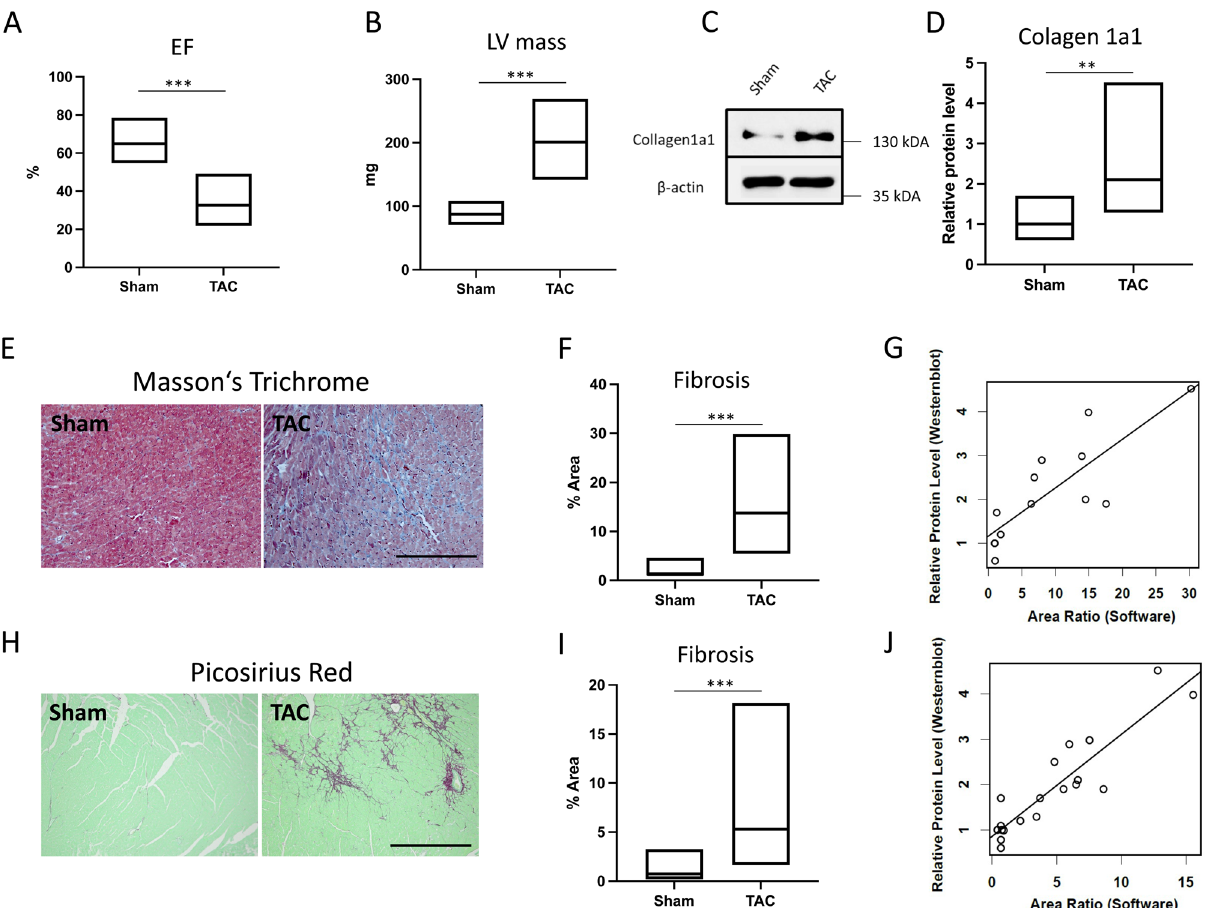
Figure 5. The results obtained by using the FibroSoft software strongly correlate with the results of Western blot analysis of collagen 1 in TAC model of heart failure. ( A ) Reduced cardiac function following TAC surgery in mice, measured by echocardiography. ( B ) Statistical quantification of left ventricular mass in mice subjected to TAC. ( C , D ) Analysis of collagen 1a1 expression in myocardium of mice by Western blot. Tubulin served as a loading control, proving equal loading of protein samples. Values were normalized to sham operated mice. ( E ) Representative images showing Masson’s Trichrome staining of cardiac paraffin sections in TAC and sham operated mice. Blue areas represent extracellular matrix deposition, while red stained tissue accounts for heathy heart muscle. ( F ) Statistical quantification of percentage fibrosis area in Masson’s Trichrome staining images, quantified by FibroSoft. ( G ) Scatter plot showing in each sample relative protein level against the surface percentage ( H ) Illustrative images showing Sirius red staining of cardiac sections in sham and TAC mice. ( I ) Quantification of percentage fibrosis area in histological sections subjected to Sirius red staining. ( J ) Scatter plot analyzing correlation between Western blot analysis and FibroSoft in sections subjected to Sirius red staining. EF: ejection fraction, LV: left ventricle. (n = 12 mice/group, 12 images analysed, *** p < 0.001, Mann–Whitney U test).